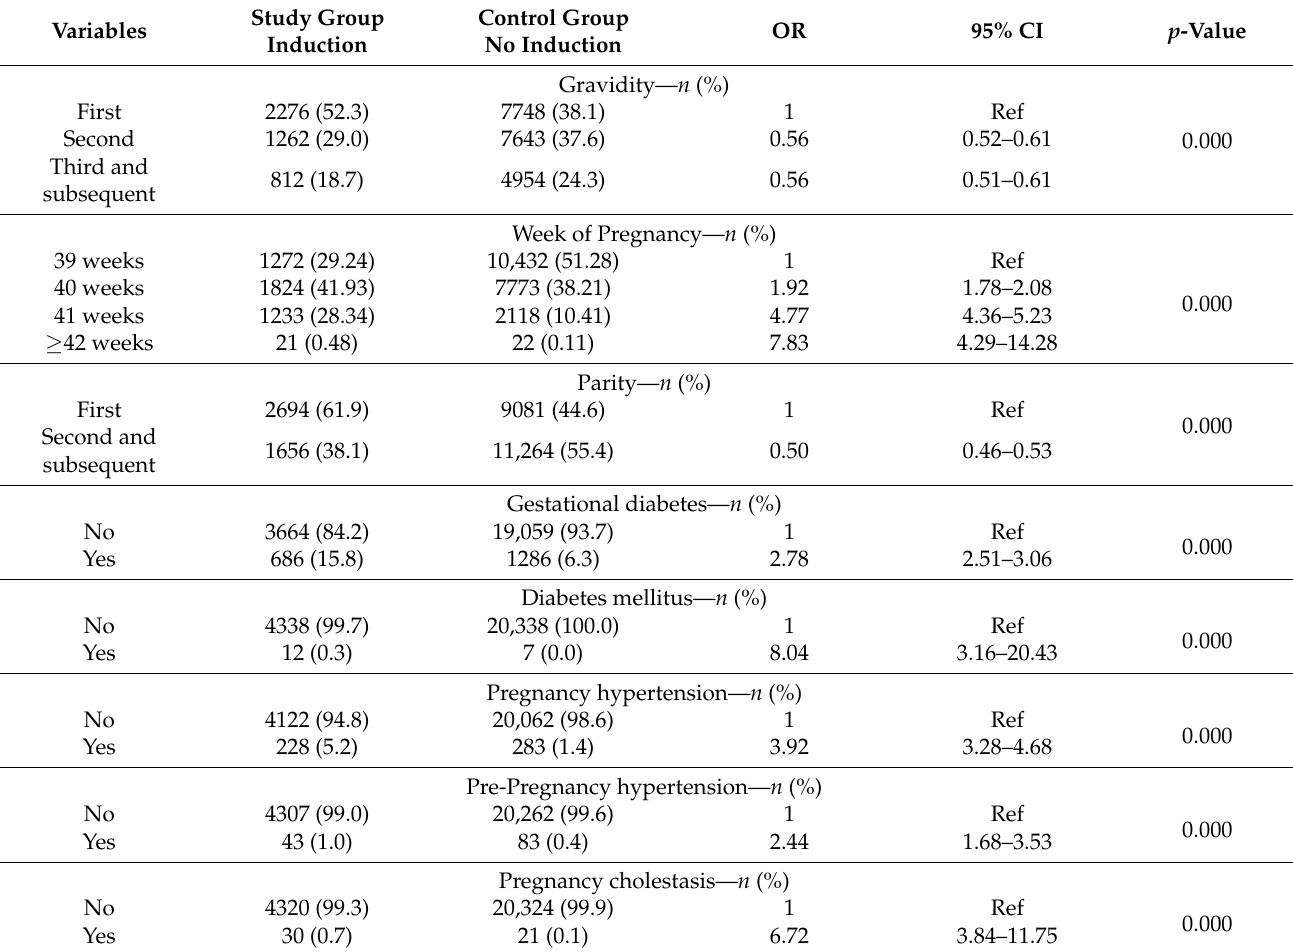
Table 2. Maternal factors occurring before induction of